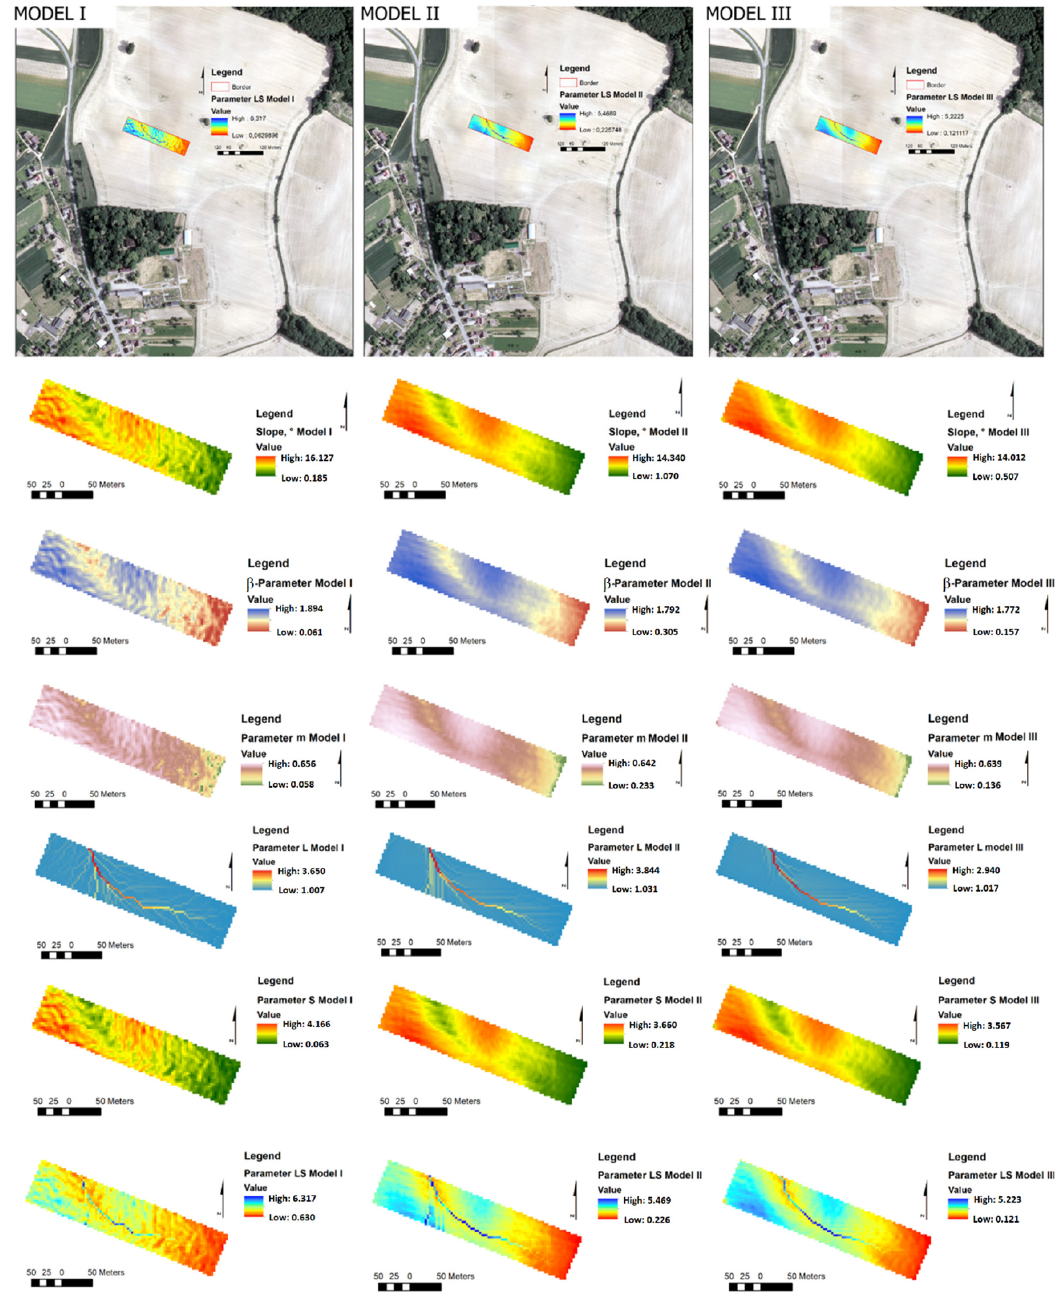
Figure 6. Maps of parameters— S [-], L [-], slope [ o ], flow direction [-], flow accumulation [-], m [-] and β [-] —obtained by three methods: Model I, aerial photographs, Model II, aerial laser scans, and Model III, terrestrial laser scans.